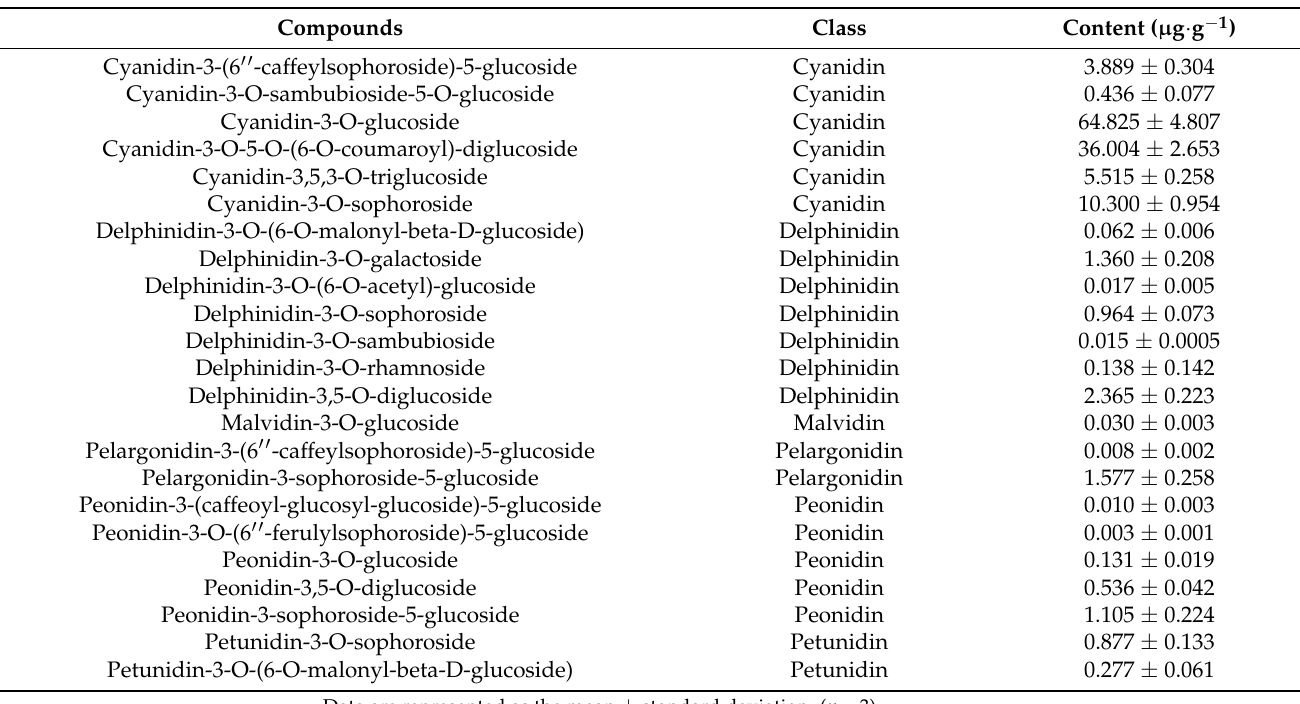
Table 1. Determination of the component and content of anthocyanins in the red leaves at S2. Compounds